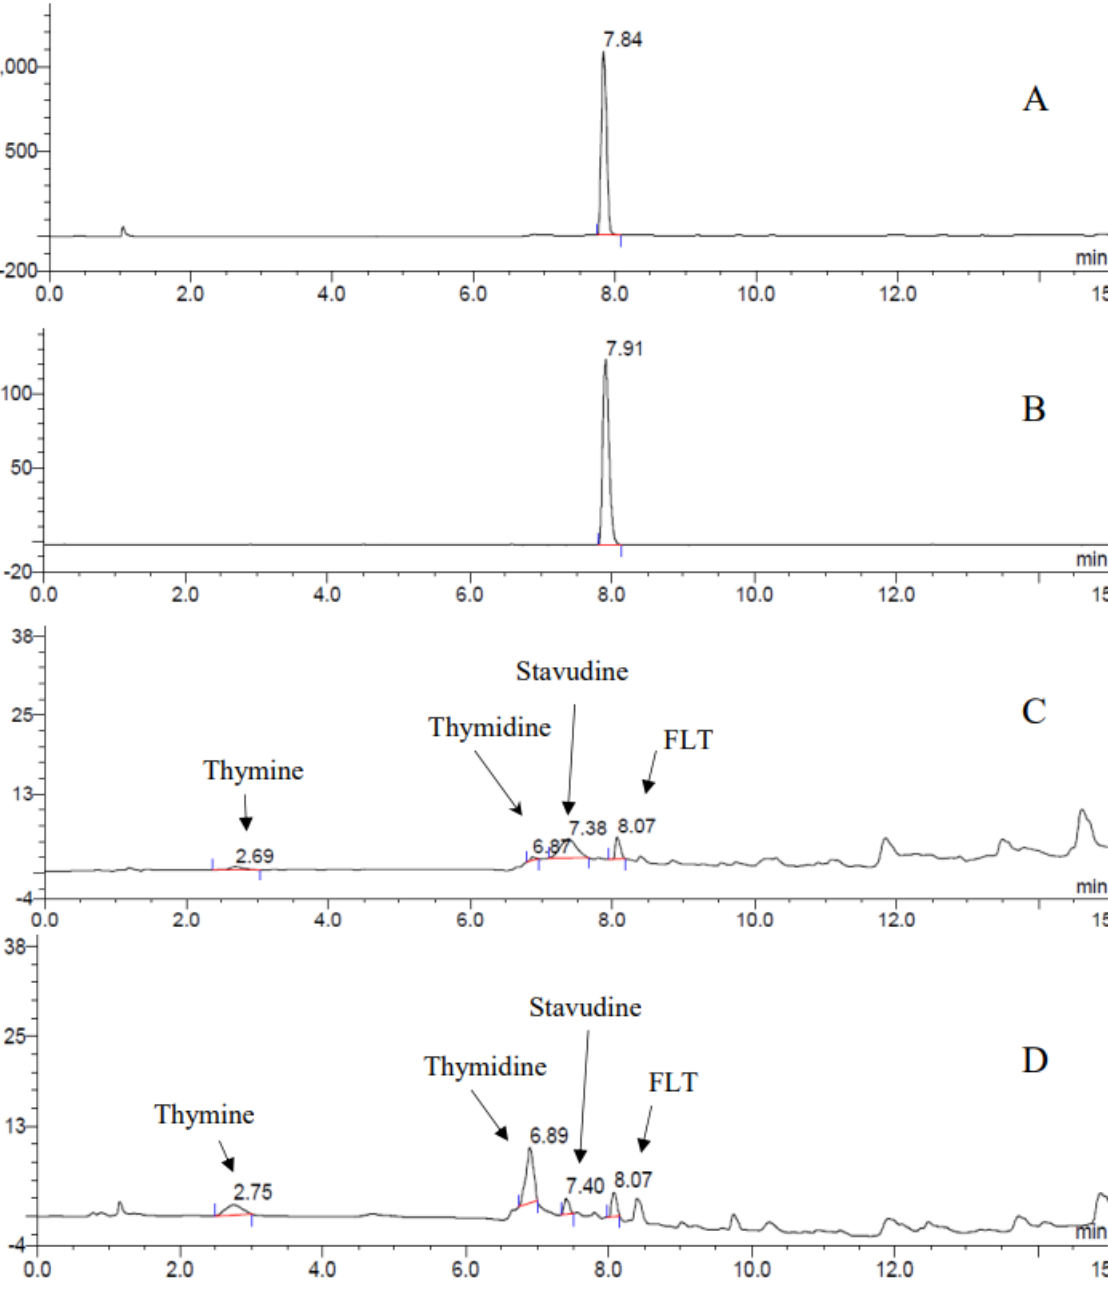
Figure 3. Representative radio- and ultraviolet (UV)—HPLC chromatogram obtained for the for- mulated [ 18 F]FLT (gradient conditions, System 1, 254 nm); ( A ) UV chromatogram of FLT authentic reference; ( B ) radioHPLC chromatogram of [ 18 F]FLT formulation; ( C , D ) UV chromatograms of two different [ 18 F]FLT